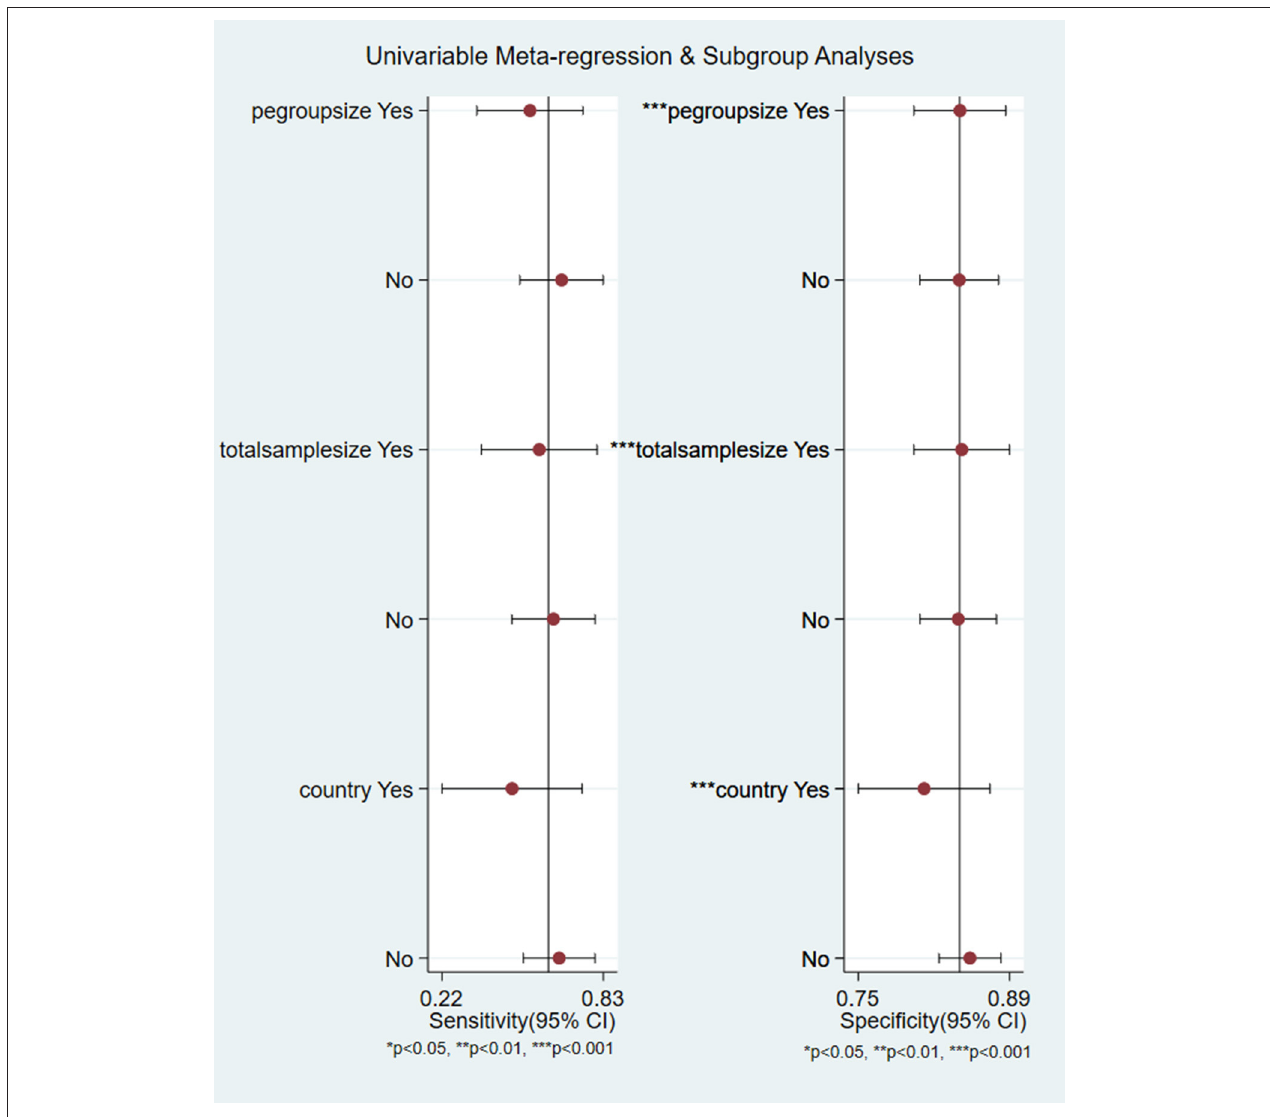
FIGURE 4 | Meta-regression analysis for all included studies. * p < 0.05, ** p <